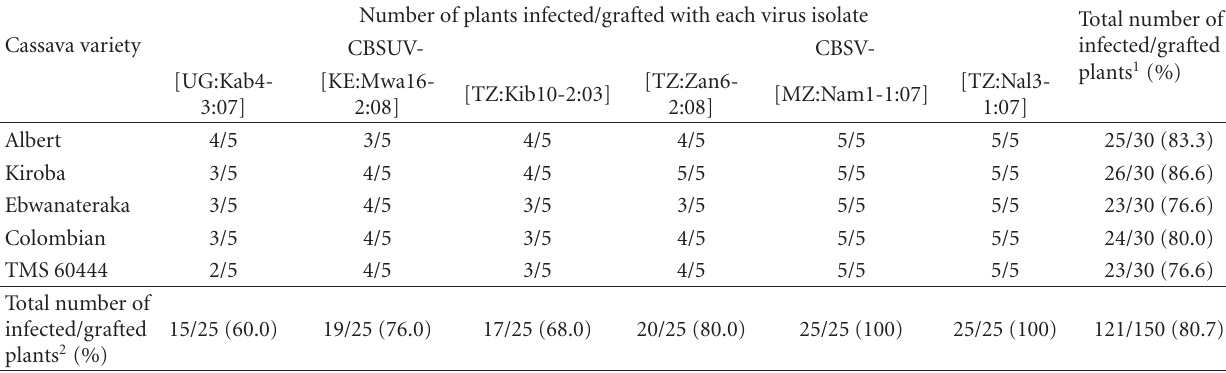
Table 3: The rate of graft transmission of six CBSD isolates to di ff erent cassava varieties. Number of plants infected/grafted with each virus Cassava variety